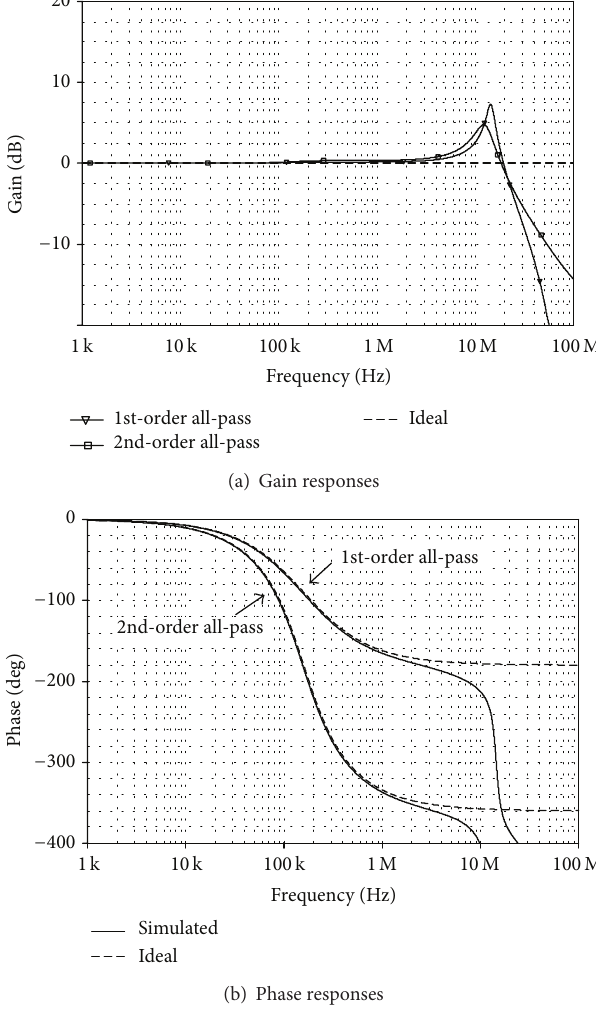
Figure 11: Simulated and ideal frequency responses of the current- mode all-pass circuit in Figure 5 when n = 1, 2.